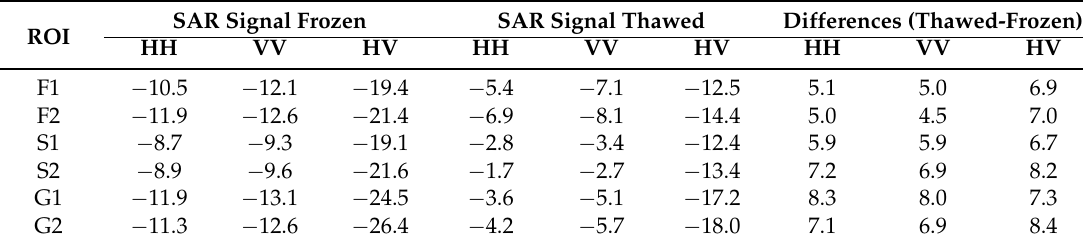
Table 1. Measured mean backscattering intensity (in dB) of ALOS PALSAR data acquired under frozen and thawed